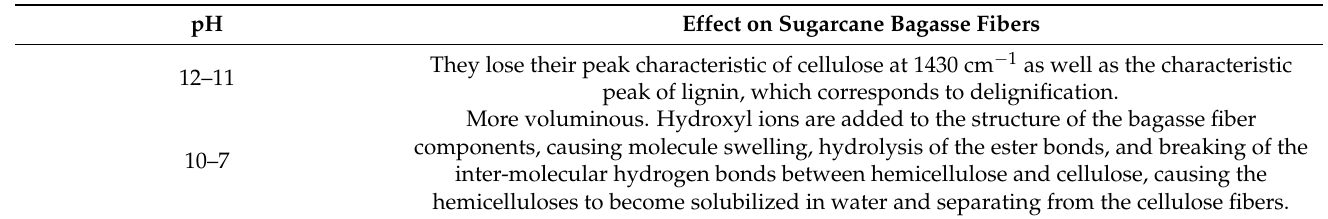
Table 2. Chemical and morphological changes in bagasse fibers as a result of pH. Effect on Sugarcane Bagasse